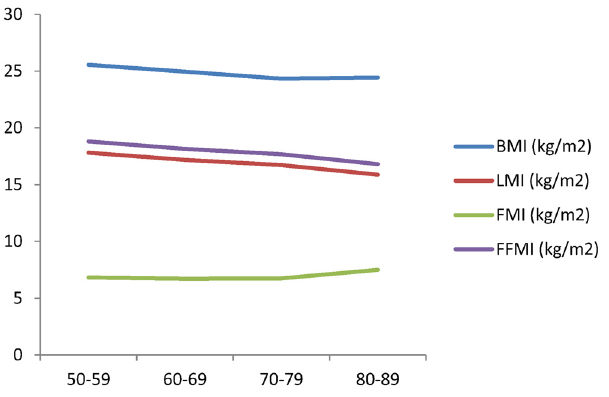
Fig 1. Trend of BMI, LMI, FMI, FFMI with aging.